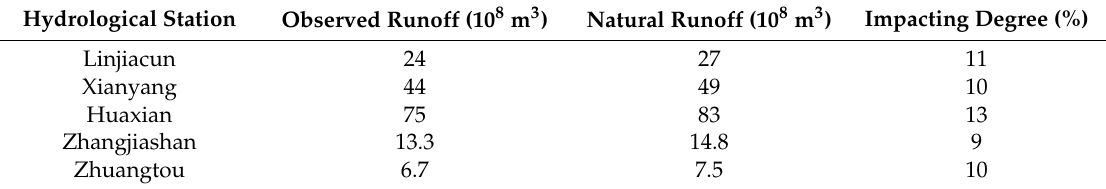
Table 5. Comparison results of observed and natural runoff in the simulation period. Hydrological